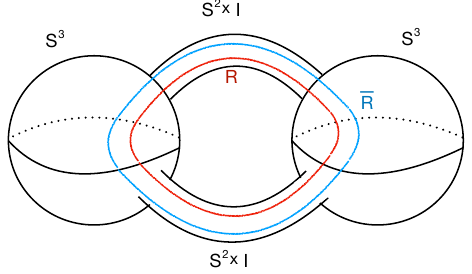
Figure 28 . Geometric representation of Z 1